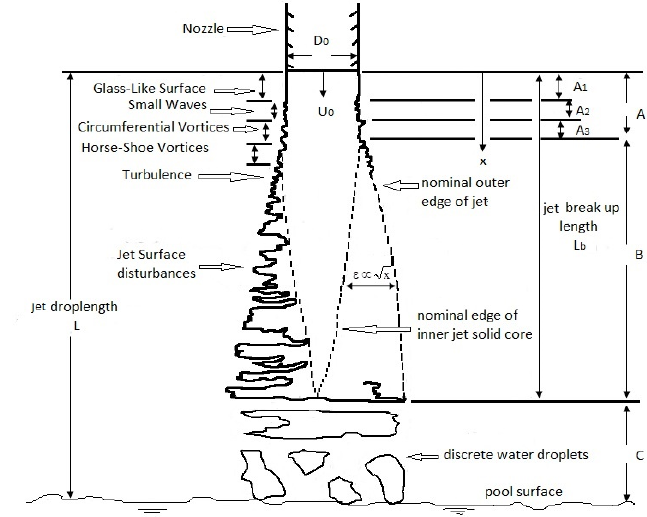
Figure 1. Features of falling jet and its development (adapted from Ervine et al. [14]).